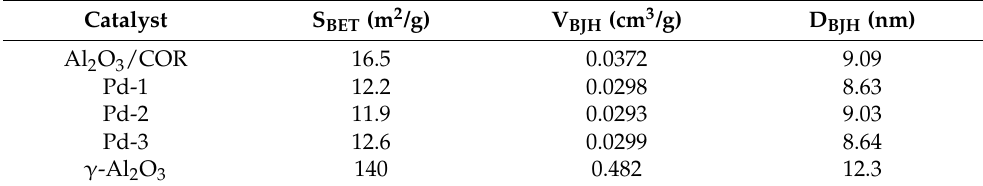
Figure 2. ( a ) N 2 adsorption and desorption isotherms of Pd-1, Pd-2, Pd-3 and Al 2 O 3 /COR at 77 K. ( b ) pore size distribution curve of Pd-1, Pd-2, Pd-3 and Al 2 O 3 /COR. Table 2. Characterization data of nitrogen adsorption and desorption of